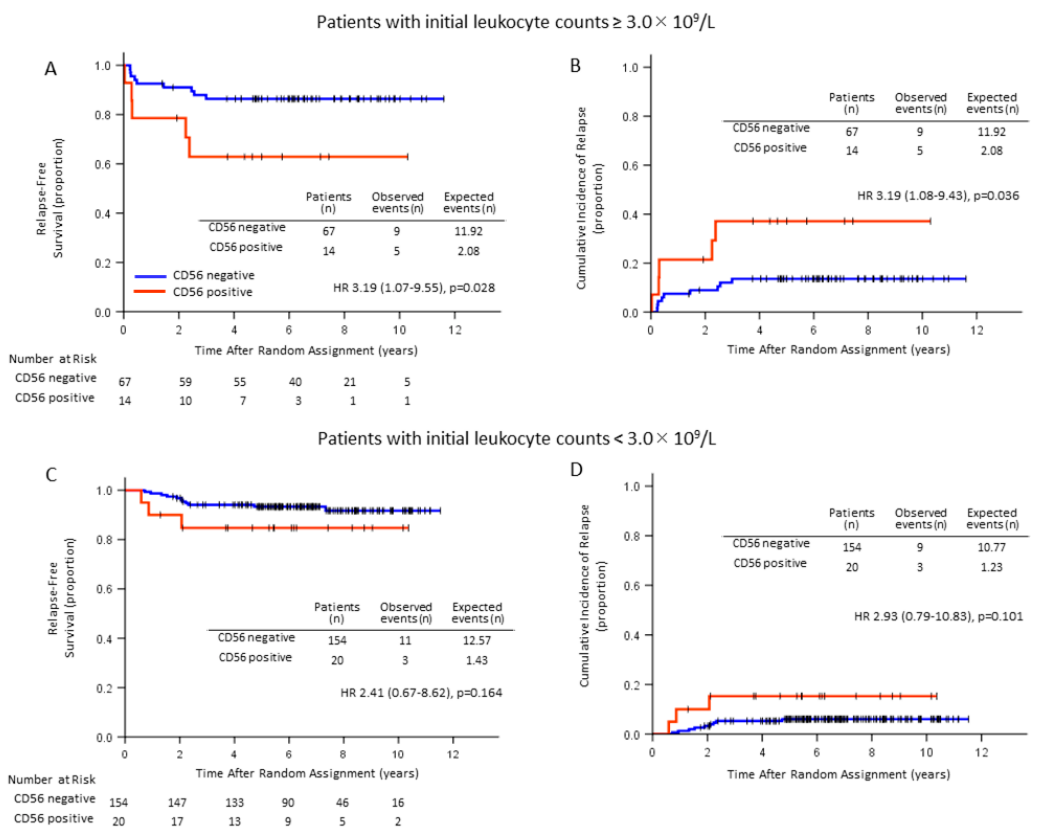
Figure 4. RFS and CIR according to CD56 expression and initial leukocyte count. RFS ( A ) and CIR ( B ) patients with an initial leukocyte count of ≥ 3.0 × 10 9 / L ( n = 81) were significantly di ff erent between CD56 + and CD56 − patients ( p = 0.028 and p = 0.036, respectively). However, CD56 + and CD56 − patients ( C and D , respectively) with an initial leukocyte count of < 3.0 × 10 9 / L ( n = 174) showed no significant di ff erence ( p = 0.164 and p = 0.101, respectively).